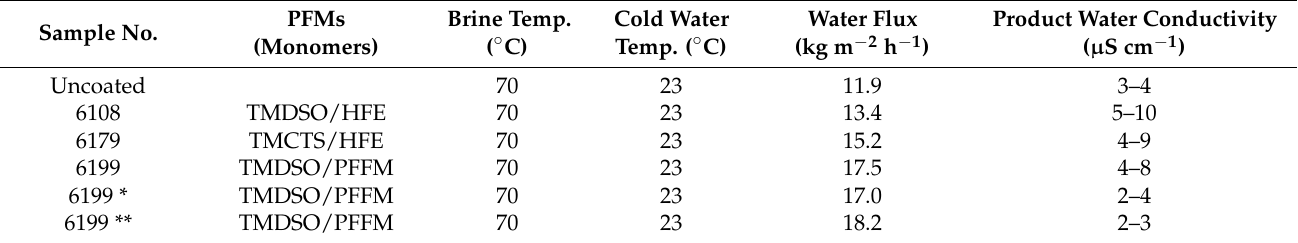
Table 8. Effect of monomer type on water flux in DCMD at feed brine concentration of 8% w / v . Sample No.